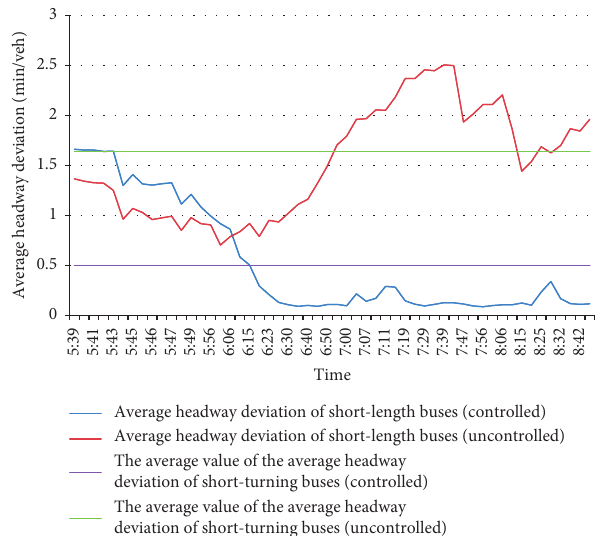
The average value of the average headway deviation of short-turning buses (controlled) The average value of the average headway deviation of short-turning buses (uncontrolled) Figure 8: Variation trend of average headway deviation of short- turning buses under controlled and uncontrolled conditions.